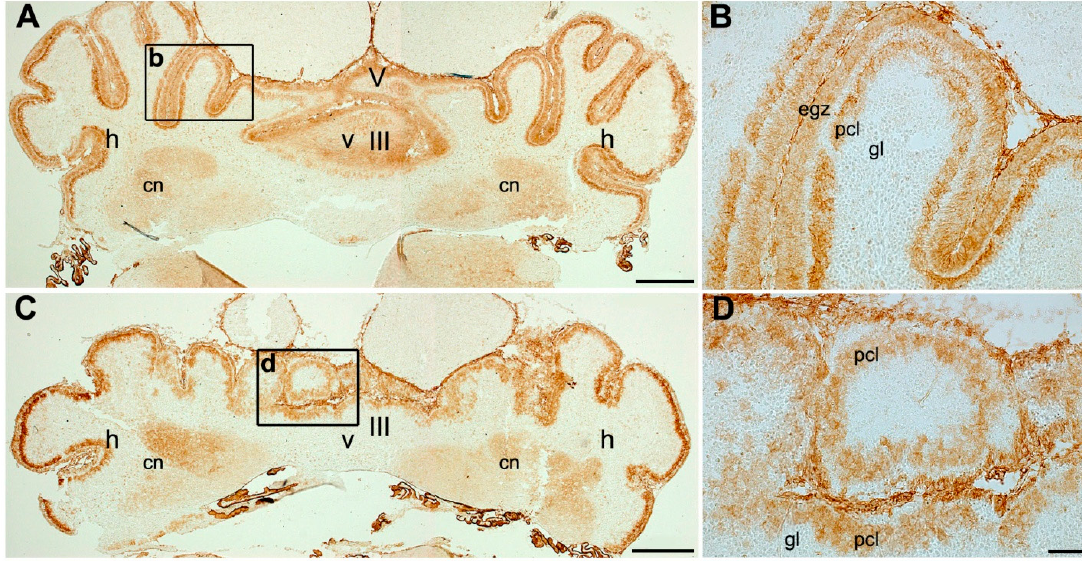
Figure 3. Frontal sections at the cerebellum of wt ( A , B ) and nax ( C , D ) at P6 immunoperoxidase stained with p75NTR. ( A , B ) The wt cerebellum shows normal vermis (v) and hemisphere (h) lobulation ( A ) with uniform expression of p75NTR in the entire cerebellar cortex. A higher magnification of black box (b) in “ A ” indicates localization of p75NTR expression in Pcl and EGZ; ( C , D ) Underdeveloped nax cerebellum exhibits uniform p75NTR expression in putative vermis and in the hemisphere. Magnified views of black box (d) in “ C ” showing p75NTR in multilayer Pc and thin or lack of EGZ. The p75NTR expression shows the outline of cerebellar nuclei (cn) both in wt ( A ) and nax ( C ) sections. Abbreviations: egz, external germinal zone; Pcl, Purkinje cell layer; h, hemisphere; cn, cerebellar nuclei; gl, granular layer. Scale bars: A and C = 500 µm; D = 100 µm (applies to B and D ).